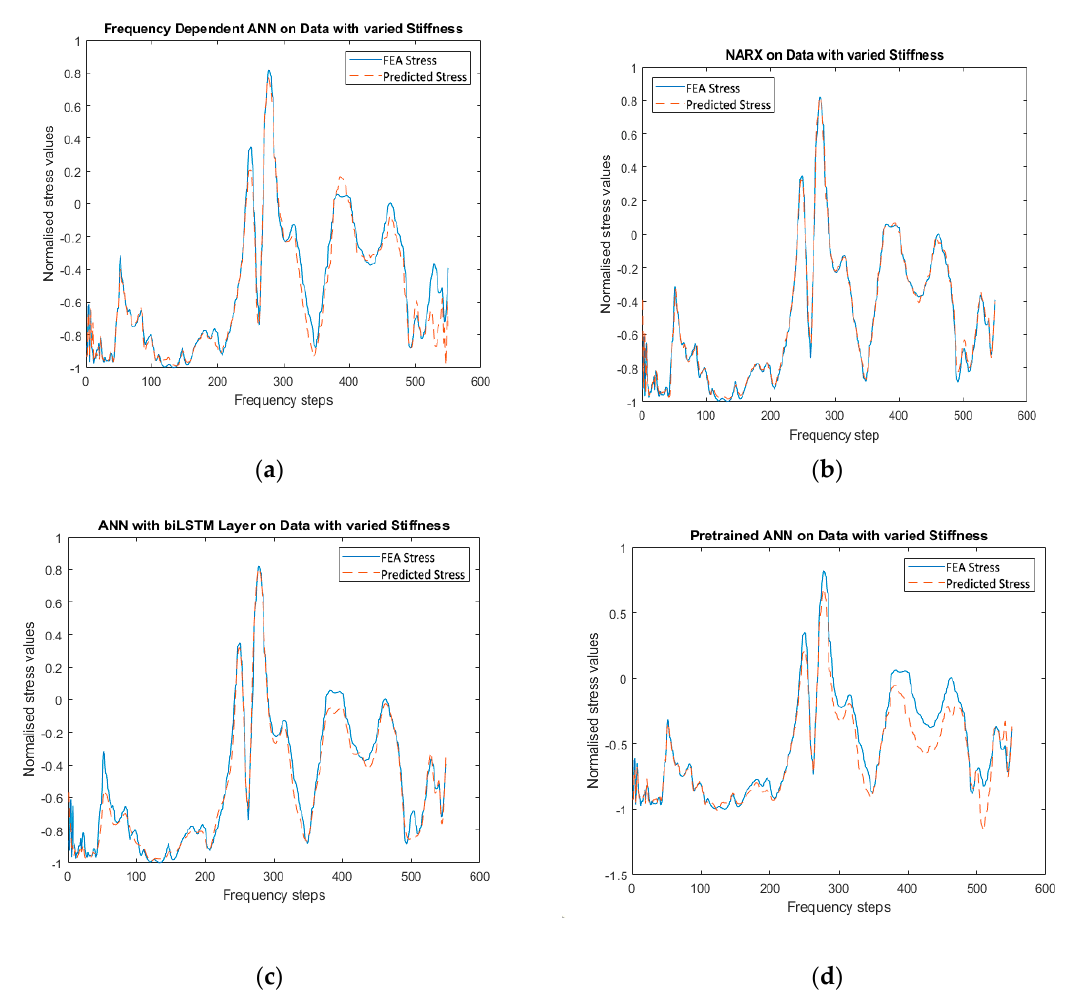
Figure 11. Stress calculated by FEA and predicted stress by ANN over the frequency steps for the NIRSpec use case: ( a ) frequency-dependent ANN, ( b ) NARX, ( c ) ANN with biLSTM layer, and ( d ) pretrained ANN.